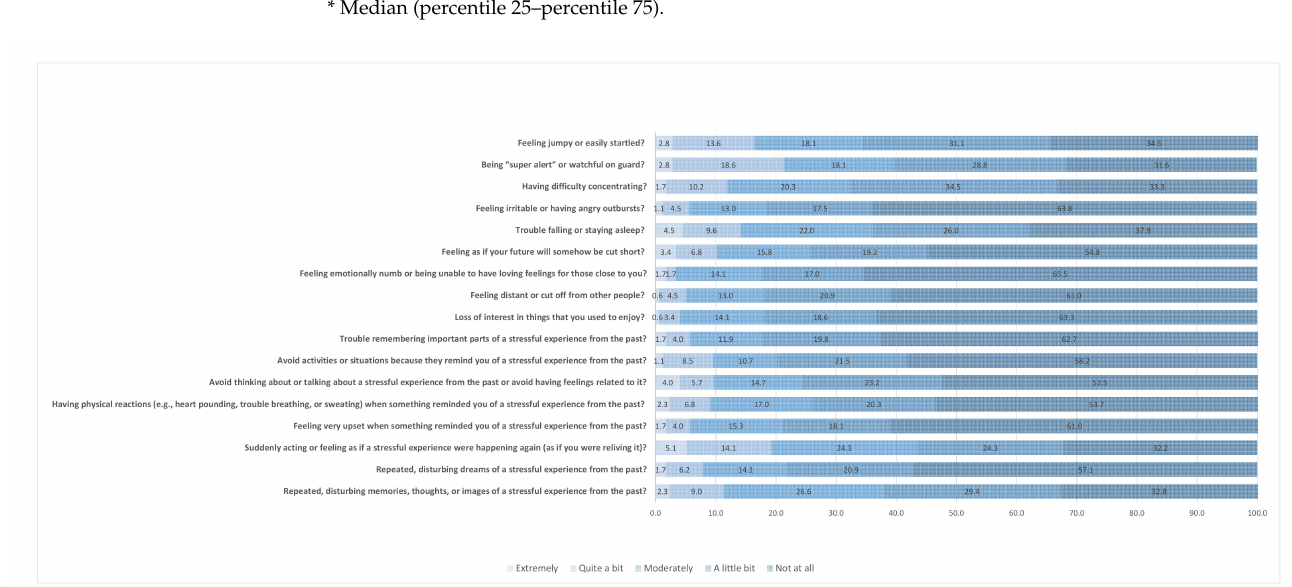
Figure 1. Frequency of PTSD symptoms according to the PCL-C items.